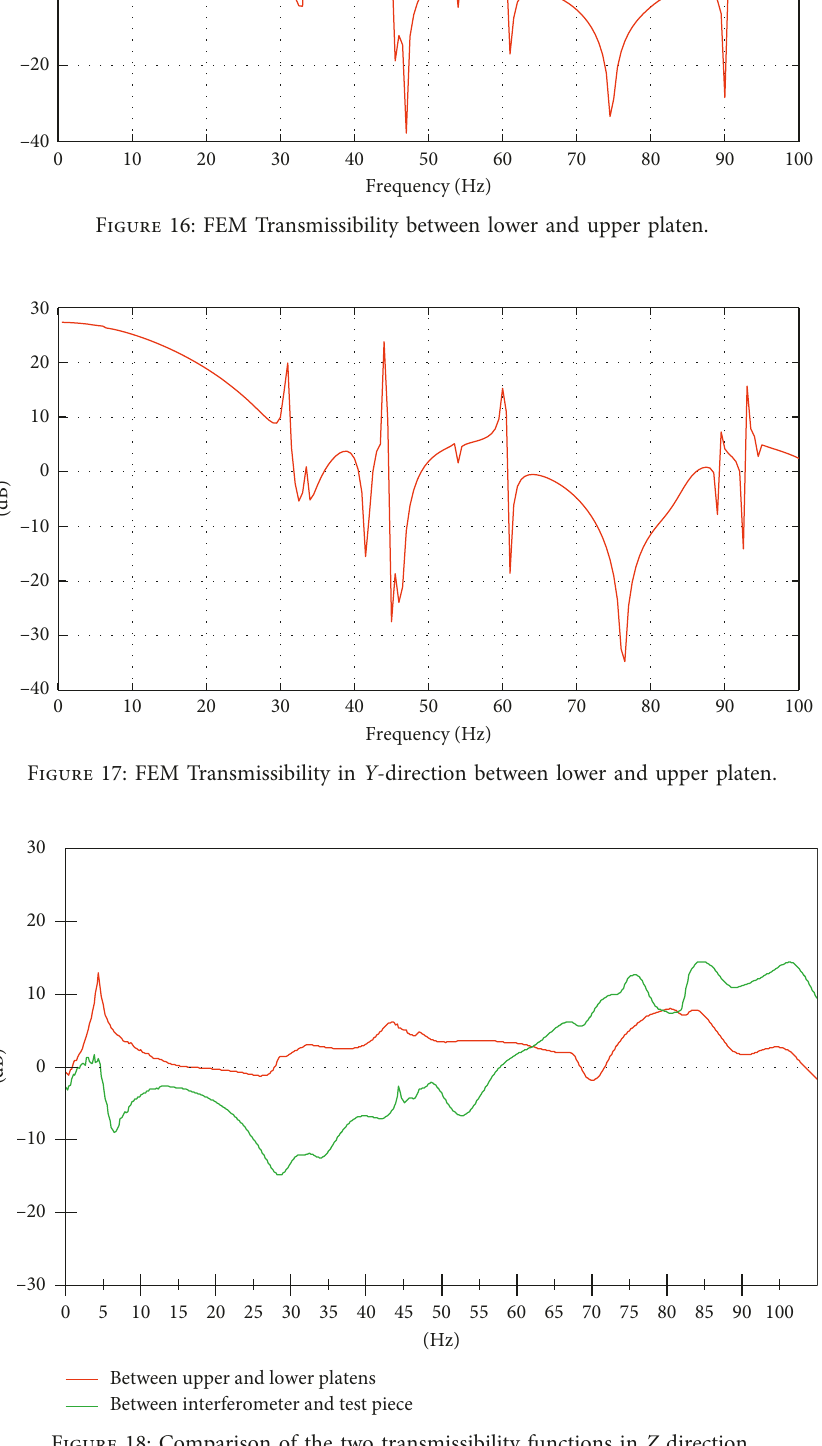
Figure 18: Comparison of the two transmissibility functions in Z